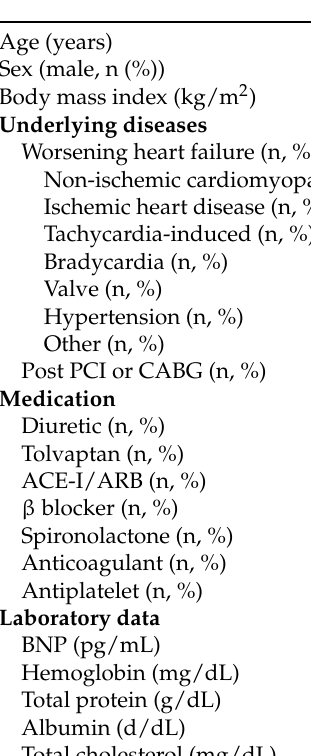
Table 1. Baseline clinical characteristics (n =